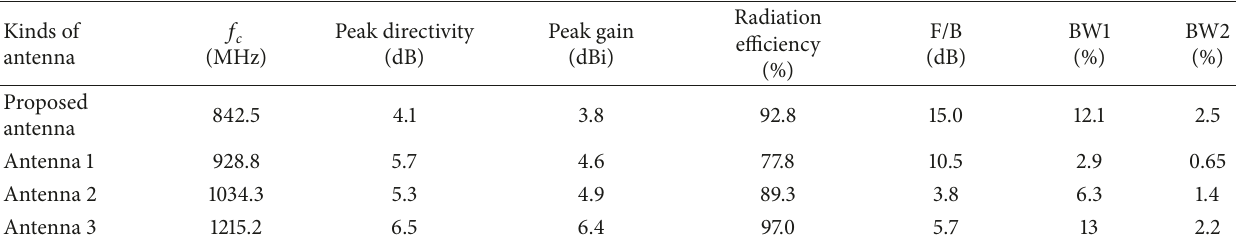
Table 2: Performance of proposed and reference antennas.